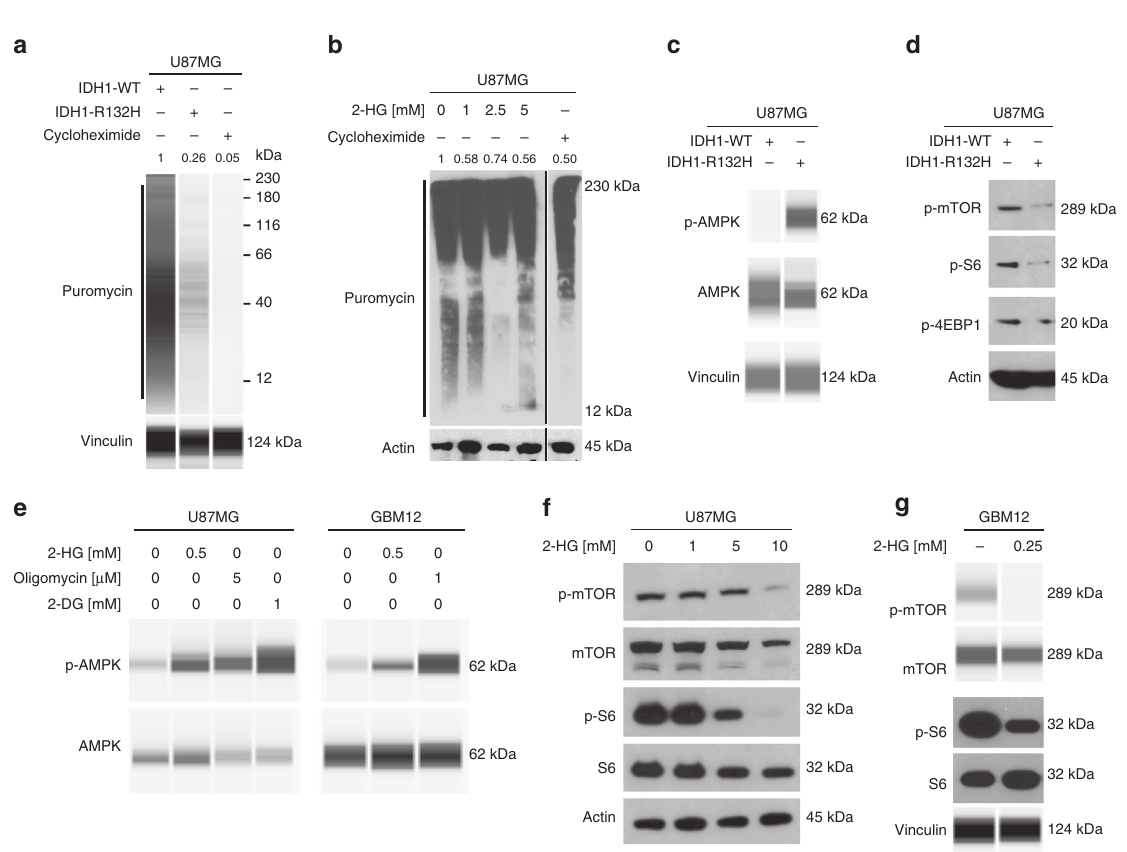
Fig. 5 Impaired protein synthesis leads to downregulation of Mcl-1 in IDH1-mutated glioblastomas. a U87MG IDH1-WT/IDH1-R132H cells were pretreated with puromycin. Whole-cell extracts were collected and capillary electrophoresis was performed for puromycin. Vinculin served as loading control. Treatment with 10 μ g ml − 1 cycloheximide served as a negative control. Densitometric analysis was performed using imageJ 1.47 v (http://imagej. nih.gov/ij). Pixel density was normalized fi rst to the respective Vinculin and second to U87MG IDH1-WT cells. b U87MG cells were treated for 24 h with increasing concentrations of 2-HG prior to incubation for 2 h with puromycin (10 μ M). Treatment with the protein synthesis inhibitor cycloheximide (10 μ g ml − 1 ) served as a negative control. Whole-cell extracts were collected prior to western blot analysis for puromycin. Densitometric analysis was performed using imageJ 1.47 v (http://imagej.nih.gov/ij). Pixel density was determined and normalized fi rst to the respective Actin signal and second to U87MG cells treated with solvent. c Whole-cell extracts of U87MG IDH1-WT/IDH1-R132H cells were collected prior to capillary electrophoresis for p-AMPK (Threonine 172) and AMPK. Vinculin served to control for equal loading. d Whole-cell extracts of U87MG IDH1-WT/IDH1-R132H cells were collected prior to western blot analysis for p-mTOR, p-S6, and p-4EBP1. Western blot for Actin was performed to con fi rm equal loading. e U87MG and GBM12 cells were treated for 48 h with 2-HG, oligomycin or 2-DG as indicated. Whole-cell extracts were collected prior to capillary electrophoresis for pAMPK